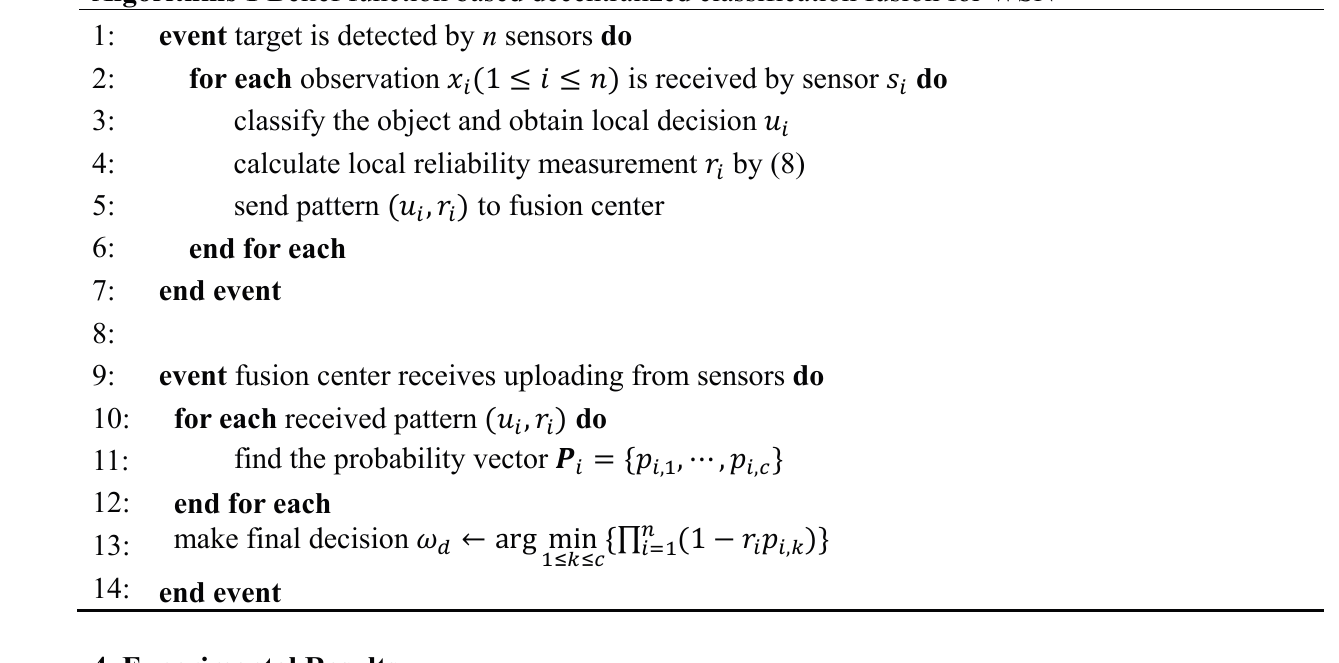
Algorithms 1 Belief function based decentralized classification fusion for